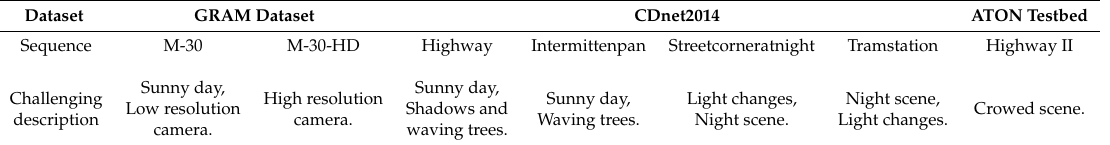
Table 3. Challenge environments information of the sequences used in the performance